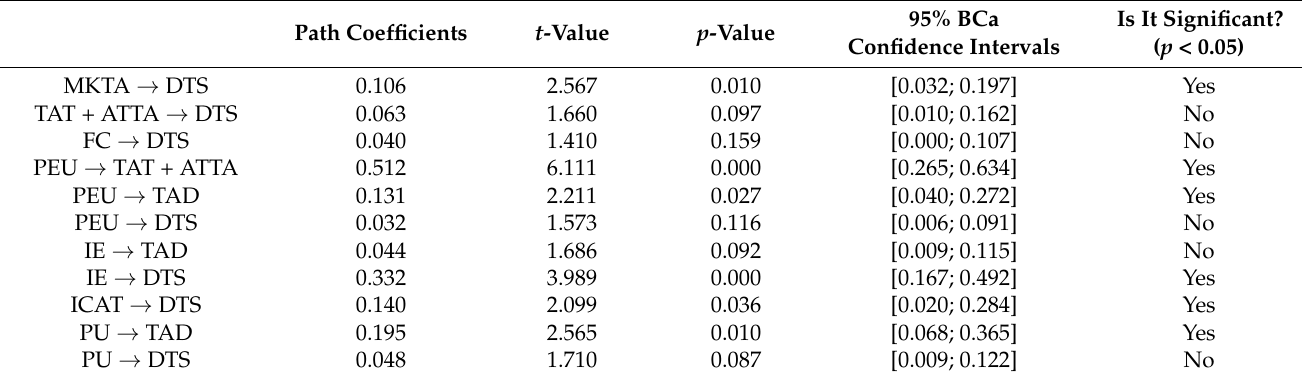
Table 12. Results of the significance tests for the total effects.